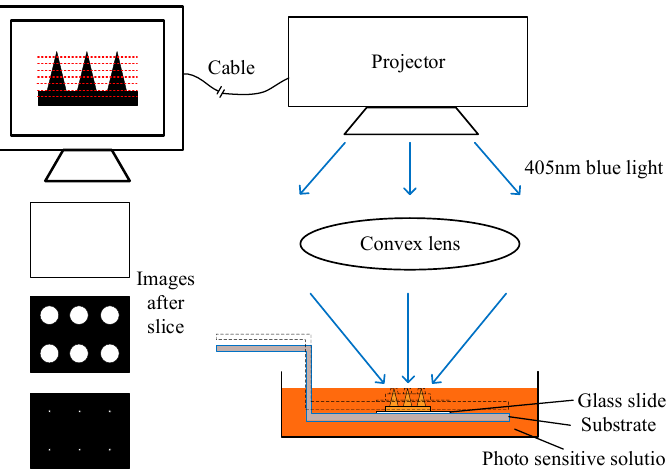
Figure 1. Simplified schematic of high-precision digital light processing (H-P DLP) system.